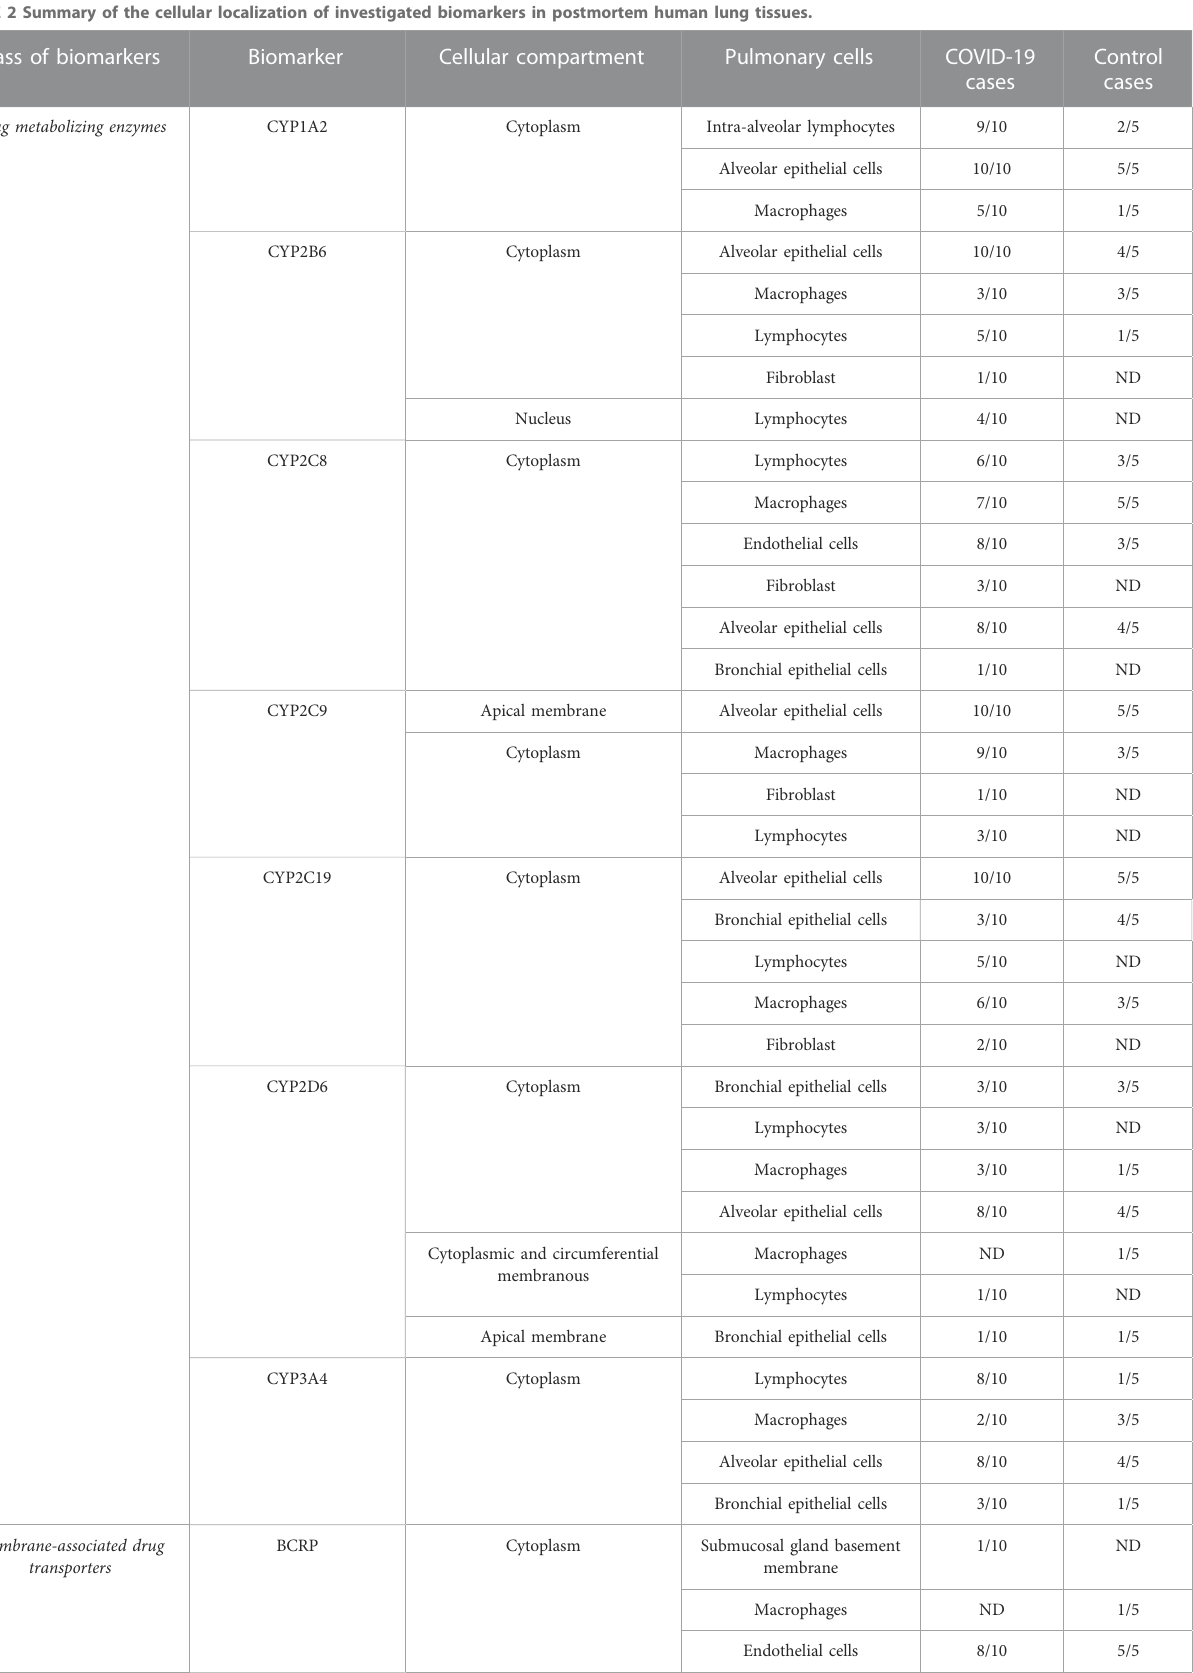
TABLE 2 Summary of the cellular localization of investigated biomarkers in postmortem human lung